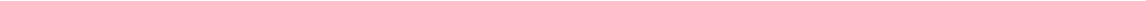
Fig. 2 NKT phenotype of + 18/32 and + 41/43 deletions. a FACS analysis of CD1d- α GalCer-tetramer + MACS-enriched NKT thymocytes in mice carrying the + 18/32 deletion compared with WT littermates (LM) mice. Stage 0 NKT (gated as Tetramer + CD24 high ) are analyzed for PLZF expression ( upper panels ). Tetramer + CD24 low NKT are stained for CD44 and NK1.1 to identify stages 1 – 3 and determine their percentages and PLZF mean fl uorescence intensity (MFI) ( bottom row ). Summary data are combined from two independent experiments, with a total of three to four mice in each group. b FACS analysis of NKT developmental stages and PLZF levels in mice carrying the + 40/43 deletion compared with WT littermate (LM). Data are combined from two independent experiments, with a total of three to fi ve mice in each group. c FACS analysis of NKT thymocytes in Zbtb16 +/ − mice. Two-tailed Student ’ s t -test was performed for statistical analysis. * P < 0.05, ** P < 0.01, *** P < 0.001, **** P <